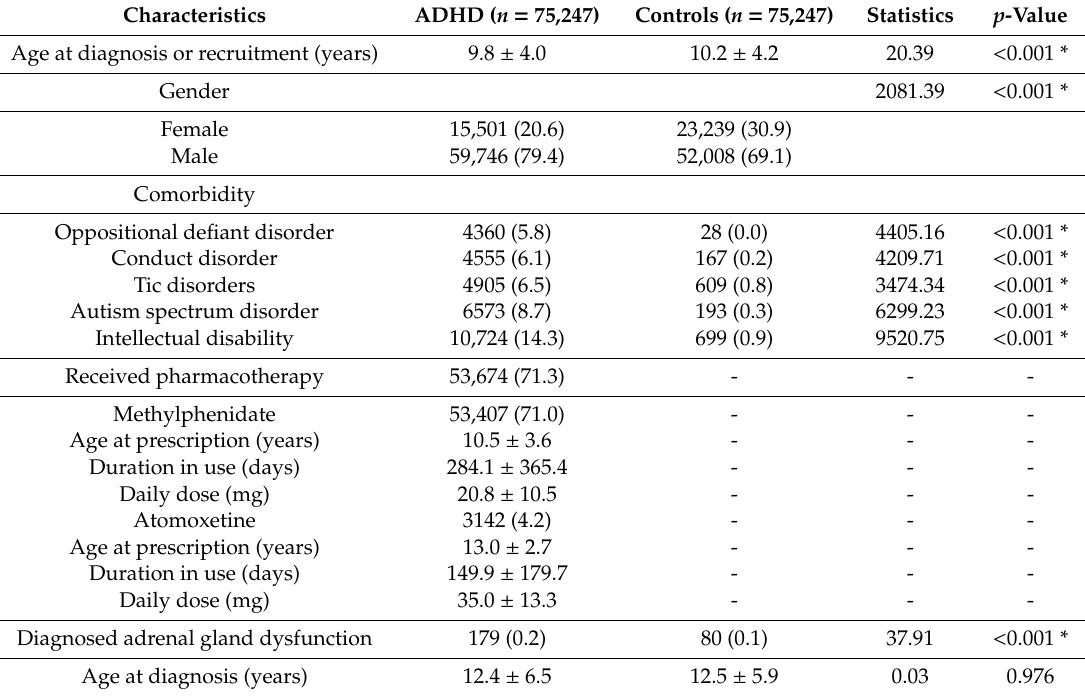
Table 1. Characteristics of patients with ADHD and control subjects in Taiwan from 2002 to 2011.